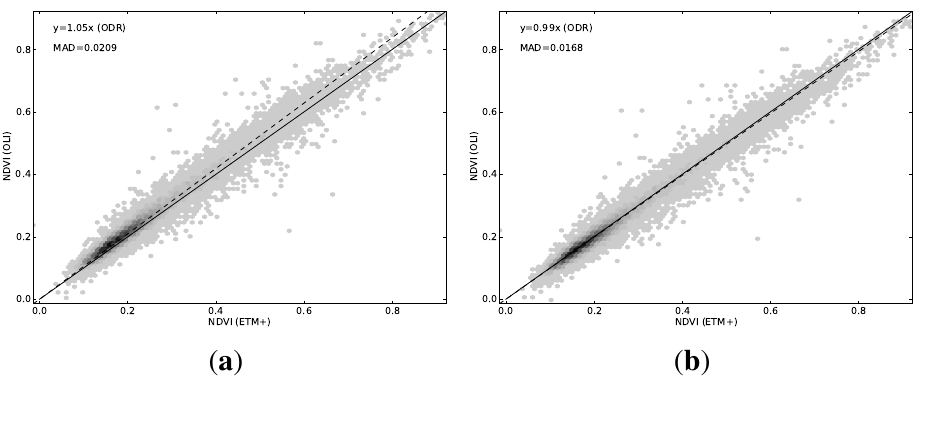
Figure 7. NDVI for Landsat-7 and Landsat-8. ( a ) NDVI using unadjusted surface